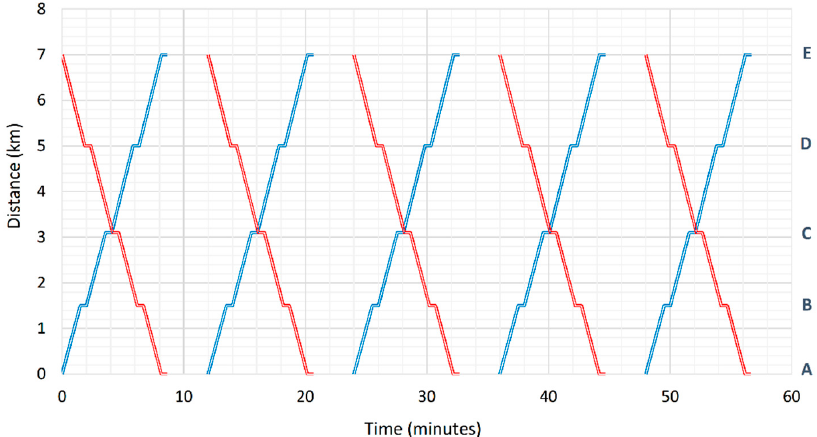
Figure A5. Simulation of 1 h tram operation between station A and B and return (12 min headway, 30 s dwell time).